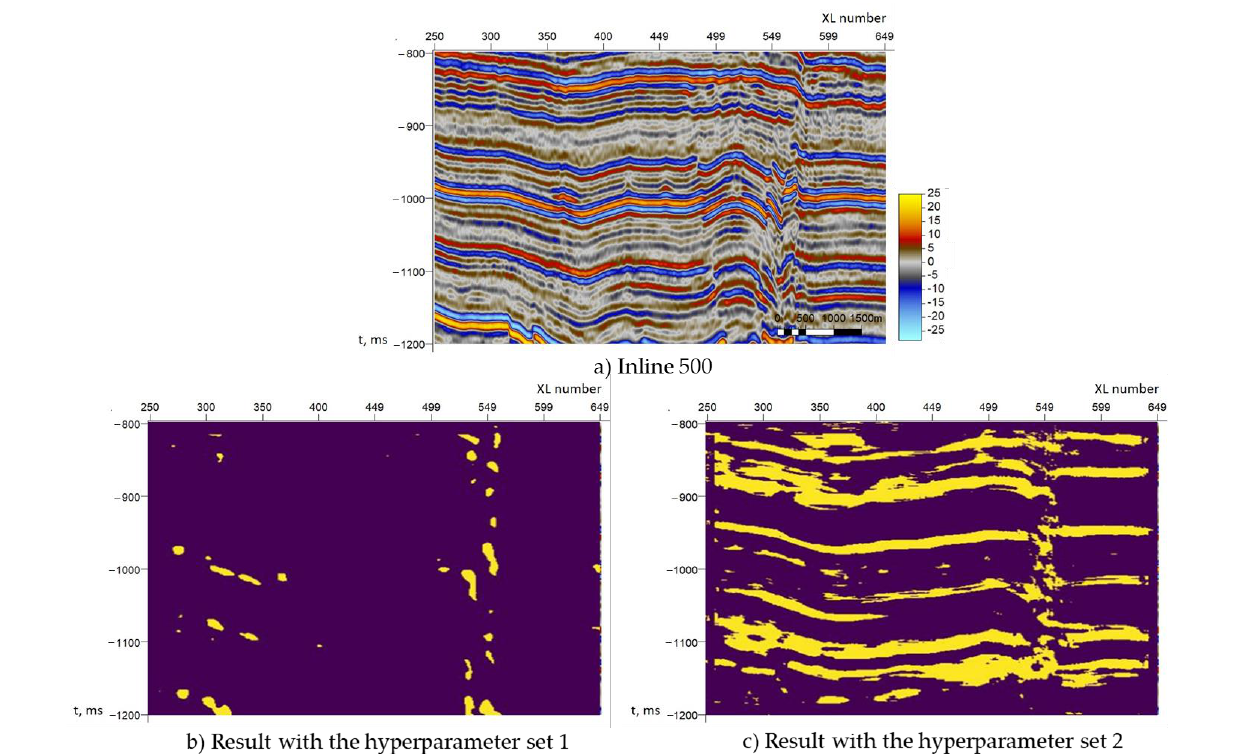
Figure 15. Inline 500 ( a ) and examples of facies predicted for it with different hyperparameters ( b , c ).